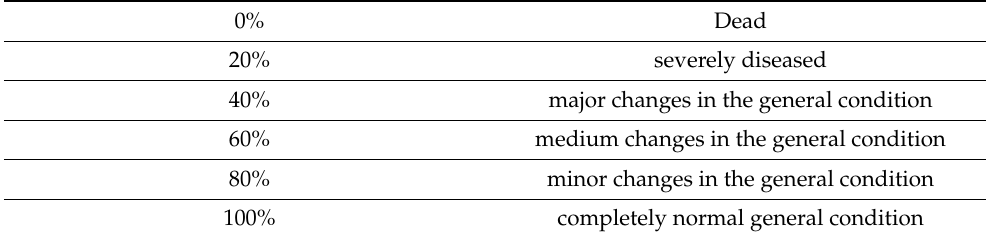
Table 1. Karnofsky’s score adapted from Hartmann and Kuffer [10,11]. Table 1. Karnofsky score modified by Hartmann and Kuffer [10,11]. Reproduced with permission from Katrin Hartmann, “Karnofsky’s score modified for cats”, European journal of medical re- search, 1998.